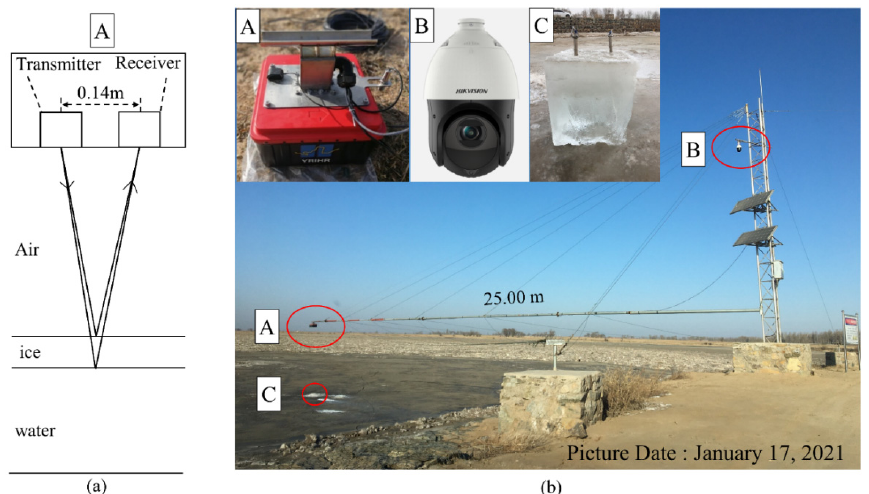
Figure 2. ( a ) Schematic diagram of radar wave propagation in ice and ( b ) H-GPR-S on the field. In ( a , b ), A is the IGPR-50 radar produced by ZOROY, B is the video camera (DS-2DC4223IW-D) produced by HIKVISION, C is the ice sample beneath A, which was taken out on 10 January 2021. The shooting direction of the background picture in ( b ) is upstream of the Shisifenzi bend in the Yellow River, but the video camera view is set to face downstream of the bend.